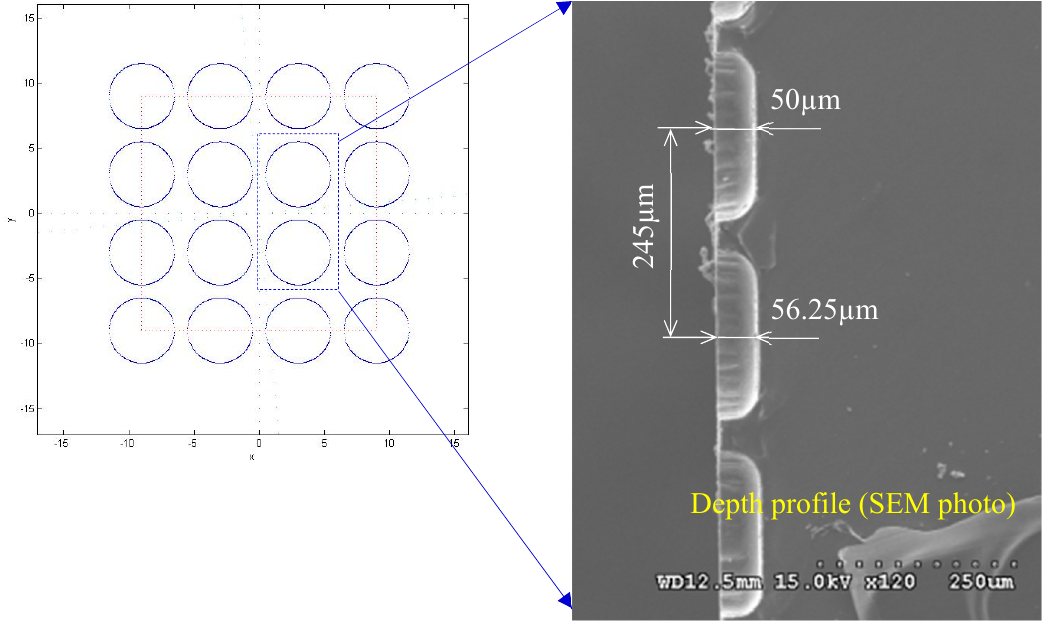
Figure 13. Simulation analysis and in-depth SEM diagram under conditions of belt rolling 𝜑 = 5°, 𝜃 = 0.04°.